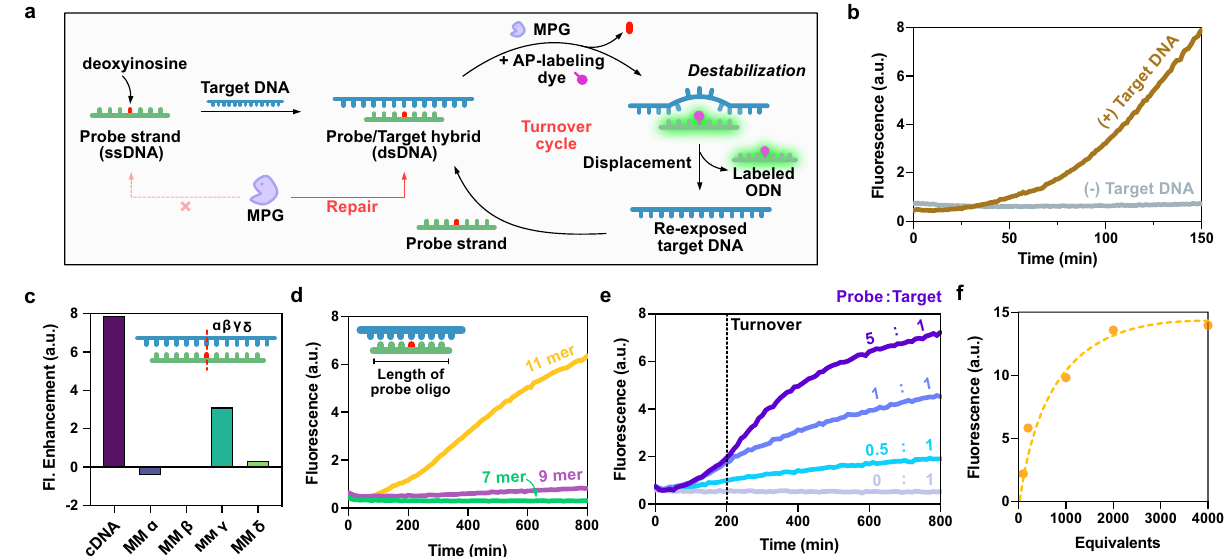
Fig.5|DetectionofatargetthroughBETrwithisothermalturnoverandsingle nucleotide speci fi city. a Illustration describing the mechanism of turnover detectionstrategy. b Fluorescenceresponsesoflabelingprobeoligo(11mer)inthe absence and presence of target DNA (Template dT). c Fluorescence enhancement upon the detection of target DNAs containing single mismatchin varied positions. d Fluorescenceresponsedependingonthelengthsofprobeoligoswhendetecting